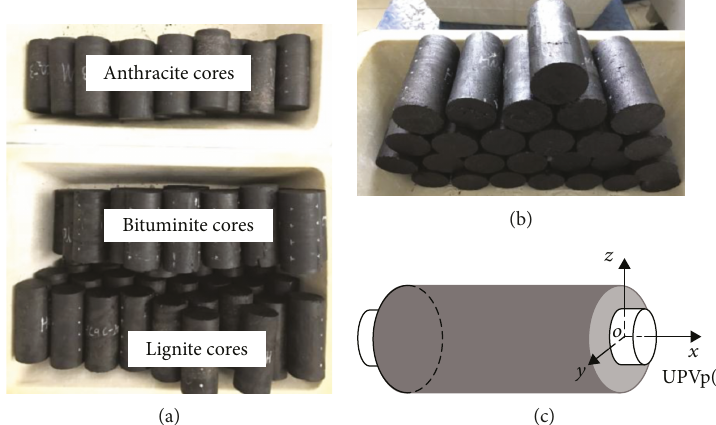
Figure 2: Images of 76 coals with di ff erent ranks. (a) Overall view of the 76 coal cores, (b) lateral display of lignite cores, and (c) sketch image of UPV test